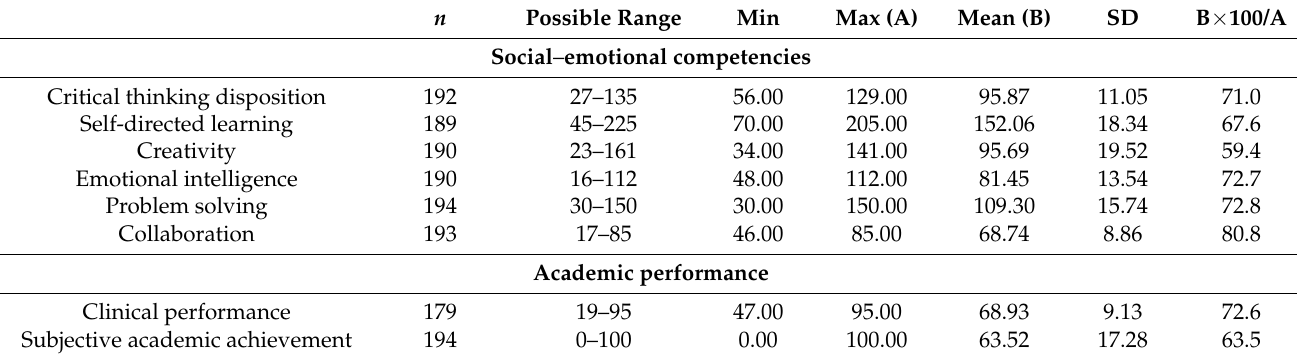
Table 2. Descriptive statistics of social–emotional competencies and academic performance ( n =